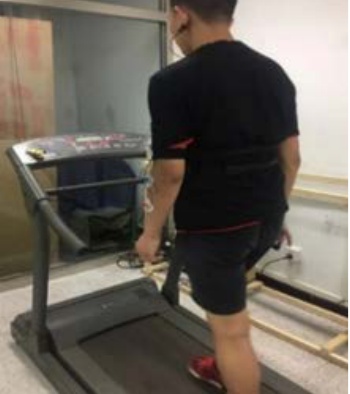
Figure 1. A treadmill used to simulate the intensity of a miner’s working.